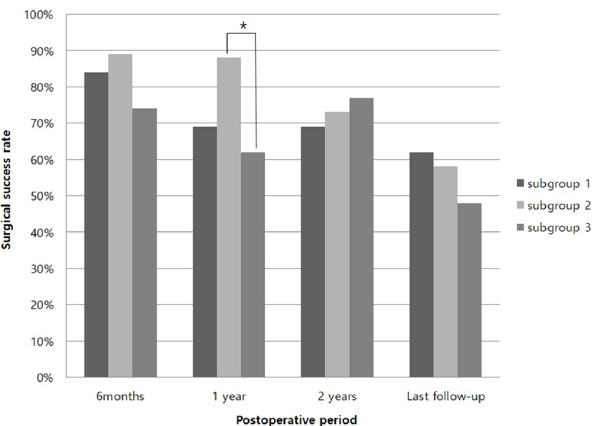
Fig 1. Surgical success rate in group Y (under 4 years old). � p < 0.05, Statistically significant (Pearson’s chi-square test). Group Y: patients under 4 years of age, Group O: patients between 4 and 16 years of age Subgroup I: postoperative 1 week esophoria-tropia (ET) � 10 prism diopters (PD), Subgroup II: postoperative 1 week ET 1-9 PD, Subgroup III: postoperative 1 week ortfaotropia or exophoria-tropia (XT).